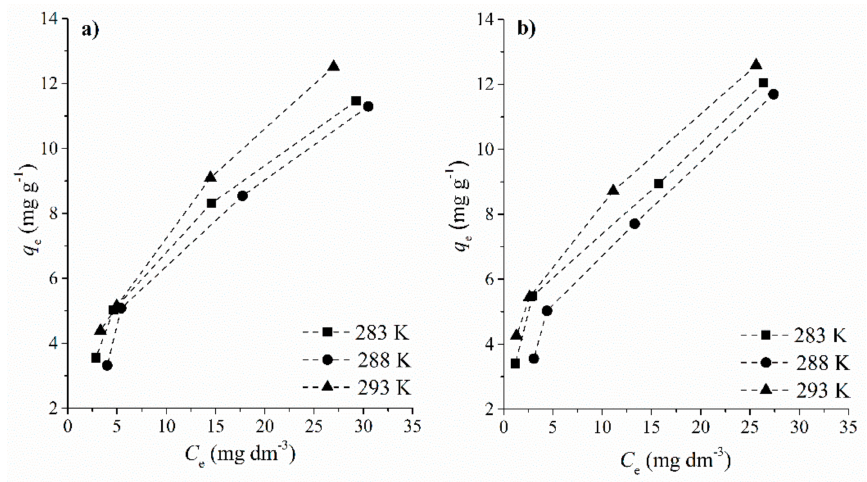
Figure 10. The adsorption isotherms for CIP on CLI ( a ) and MAG-CLI ( b ); q e is the amount of the adsorbed CIP (mg per 1 g of CLI or MAG-CLI) and C e is the CIP solution concentration at